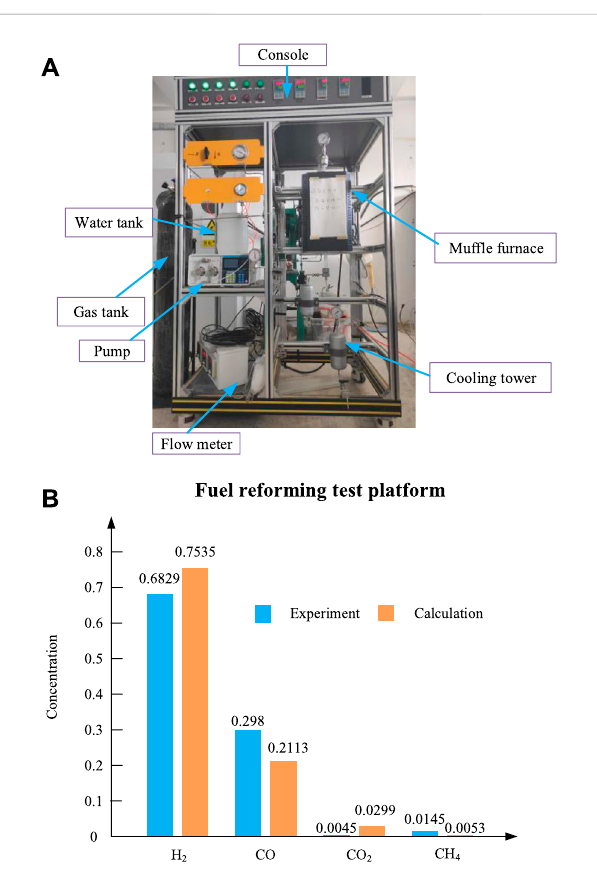
FIGURE 3 Fuel reforming test platform and methane steam reforming results. (A) Fuel reforming test platform. (B) Comparison between the fuel reforming model and experiment.